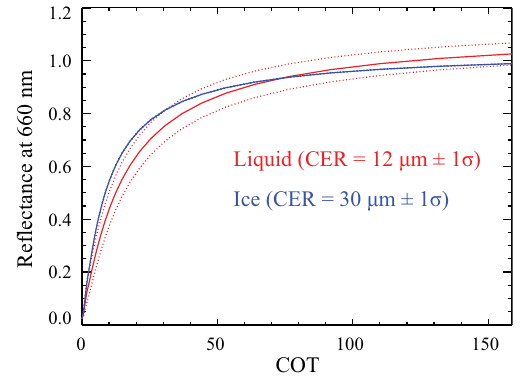
Figure 4. Gridded monthly cloud thermodynamic phase agreement fraction, defined as the fraction of cloudy pixels for which the proxy EPIC algorithm results agree with those from the multiple- test MOD06 algorithm, i.e., the gridded sum of the diagonal of the skill table in Fig. 3.